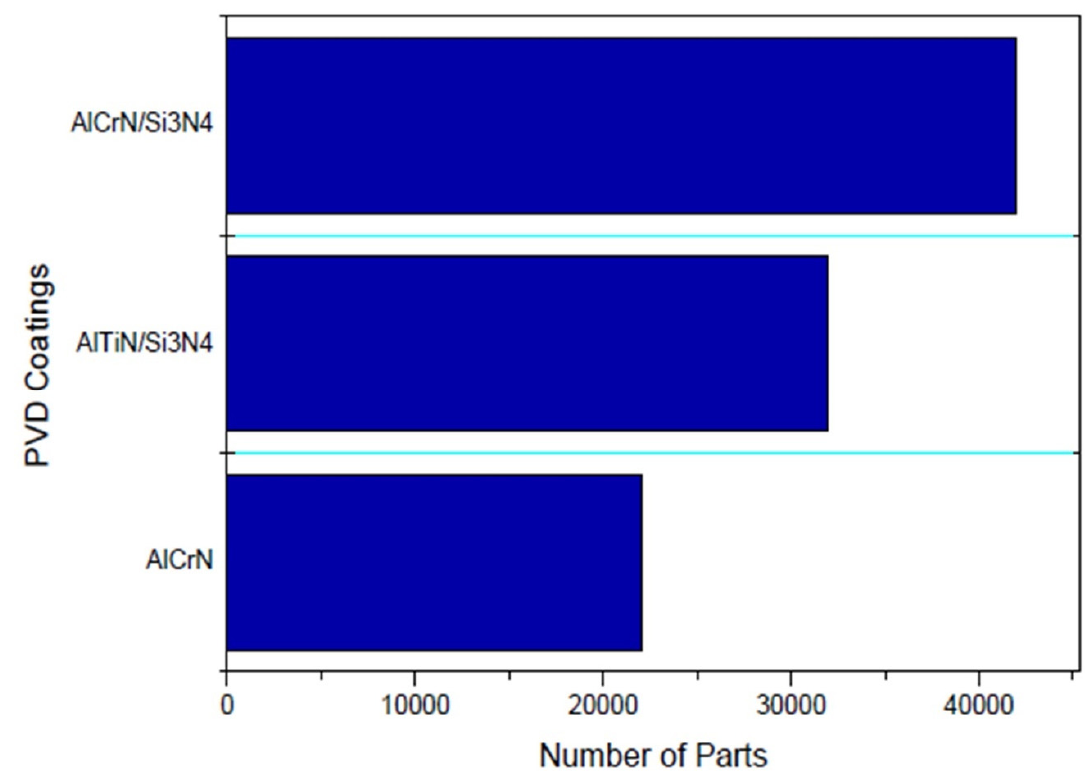
Figure 17. Number of parts produced by high-pressure die casting (HPDC) until defected parts are produced [206].